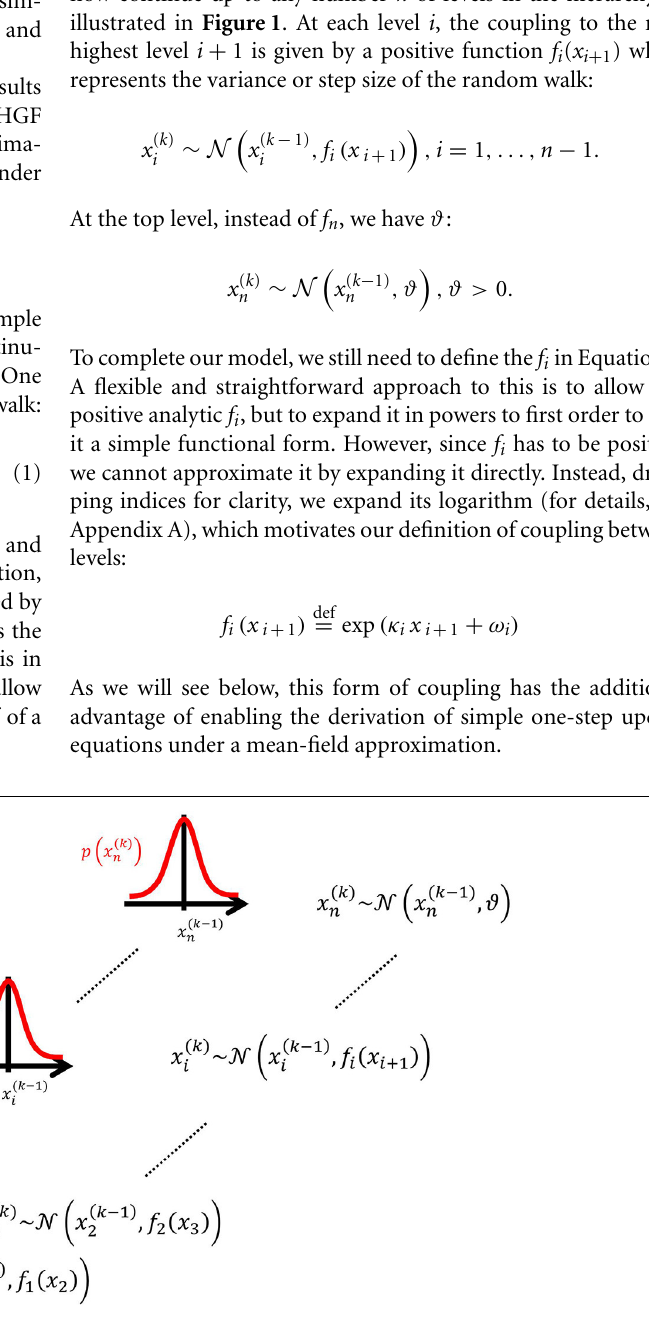
FIGURE 1 | Overview of the Hierarchical Gaussian Filter (HGF). The model represents a hierarchy of coupled Gaussian random walks. The levels of the hierarchy relate to each other by determining the step size (volatility or variance) of a random walk. The topmost step size is a constant parameter ϑ